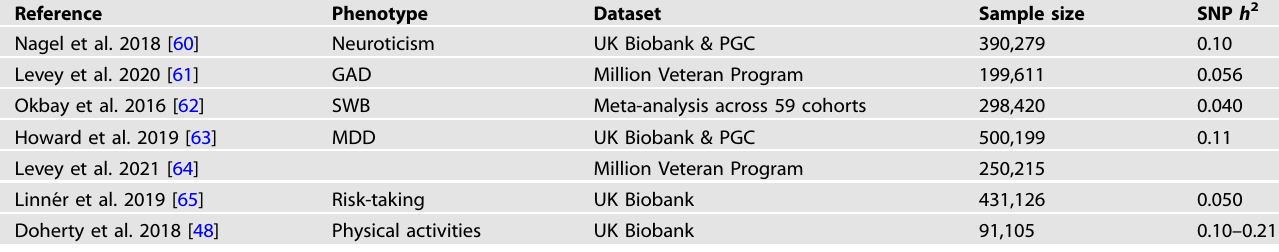
Table 2. Summary statistics from GWAS